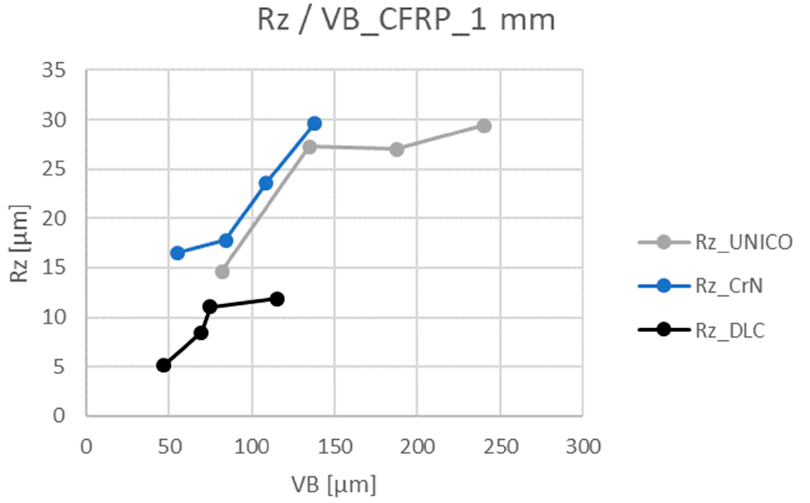
Figure 19. Dependence of the surface roughness parameter R z on wear, laminate thickness 1 mm. R z —maximum height of profile. VB—flank wear.